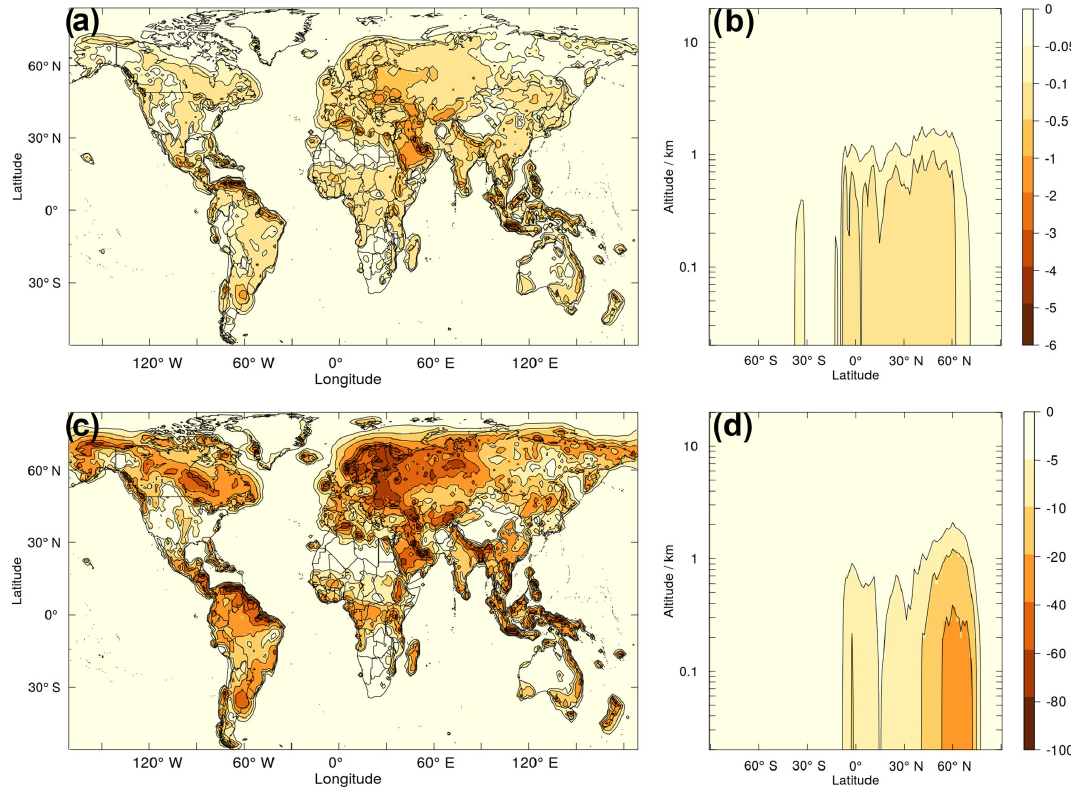
Figure 7. Annual mean change in OH concentration following inclusion of Reaction (R3): absolute change in 10 6 moleculescm − 3 (a) at the surface and (b) as a zonal mean, and relative percentage change (c) at the surface and (d) as a zonal mean.